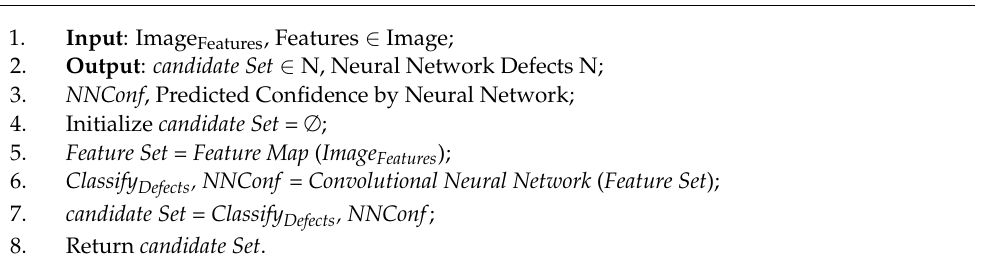
Algorithm 3 AOI for Neural Network